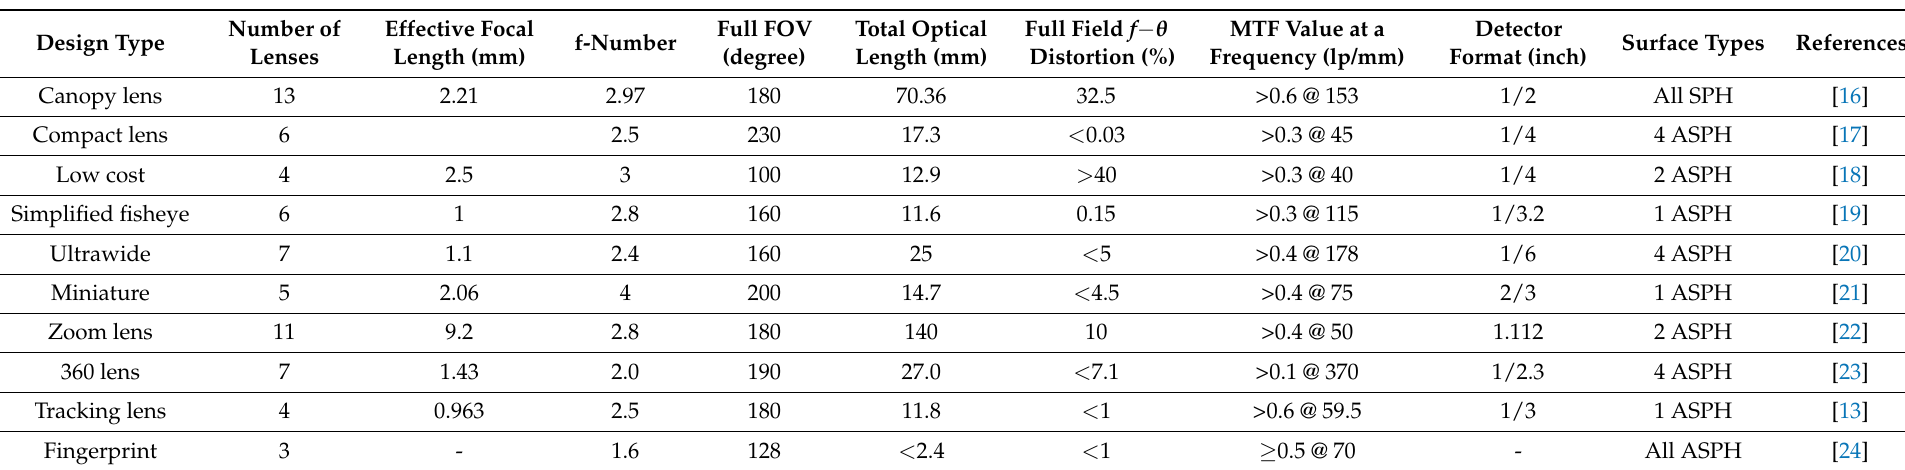
Table 2. State-of-the-art research WFOV visible and near-infrared imaging